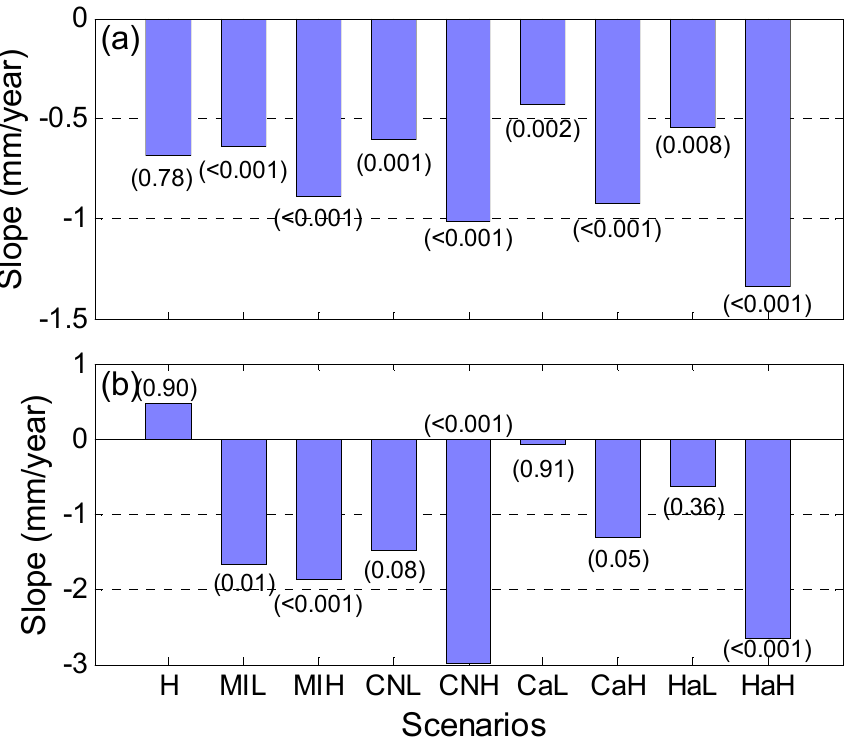
Figure 8. Trend Slope of 1 April Snow Water Equivalent for ( a ) SAC4 and ( b ) SJQ4 during historical (1930–1999) and projected periods (2020–2099) under different scenarios. Value in the bracket represents the corresponding p -value. H: historical; MIL: MIROC5 RCP 4.5; MIH: MIROC5 RCP 8.5; CNL: CNRM-CM5 RCP 4.5; CNH: CNRM-CM5 RCP 8.5; CaL: CanESM2 RCP 4.5; CaH: CanESM2 RCP 8.5; HaL: HadGEM2-ES RCP 4.5; HaH: HadGEM2-ES RCP 8.5. Appendix A provides the corresponding data